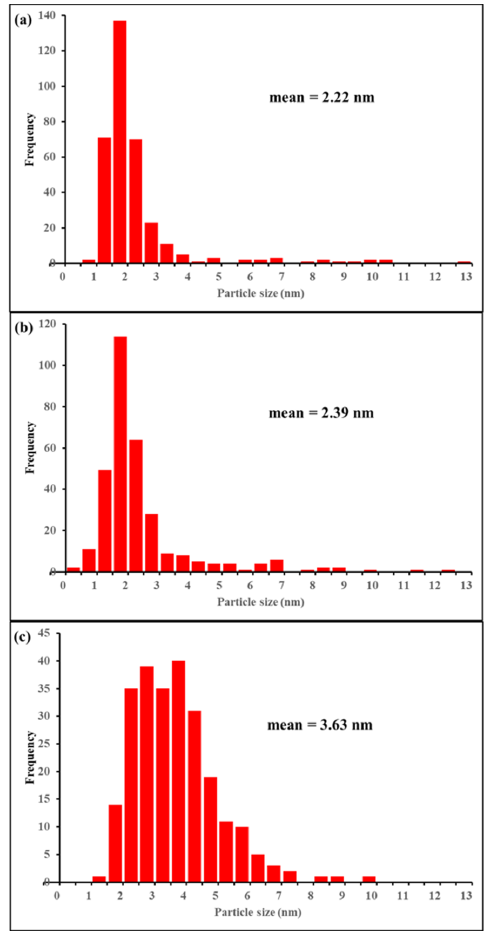
Figure 3. Pd nanoparticle size distribution histograms obtained from TEM images for catalyst samples after catalyst testing: ( a ) IW-Pd ( b ) DS-Pd; ( c ) SL-Pd.